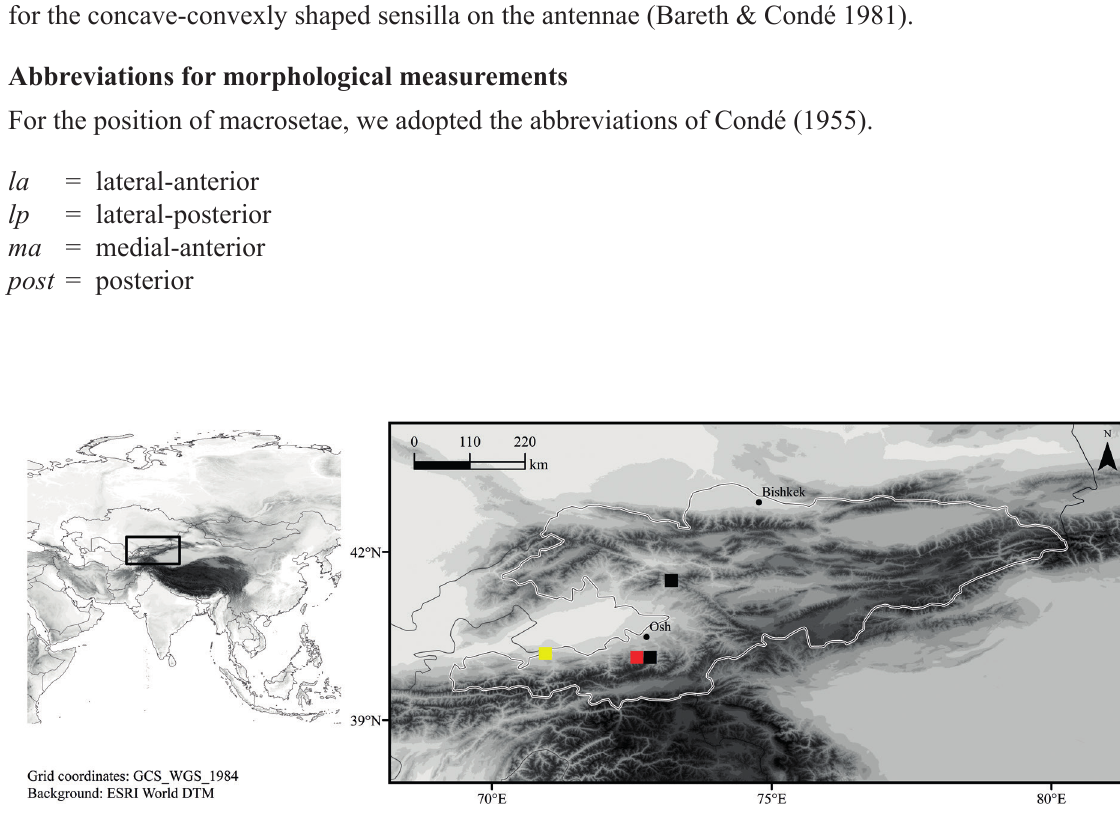
Fig. 1. Relief map of part of Asia with detail of Kyrgyzstan and adjacent regions with the localities at which diplurans were found; Kyrgyzstancampa sanare Sendra & Ferreira gen. et sp. nov. (yellow square); Campodea ( Dicampa ) catalana Denis, 1930 (red square); Turkmenocampa edaphica Sendra & Sánchez-García sp. nov. (black